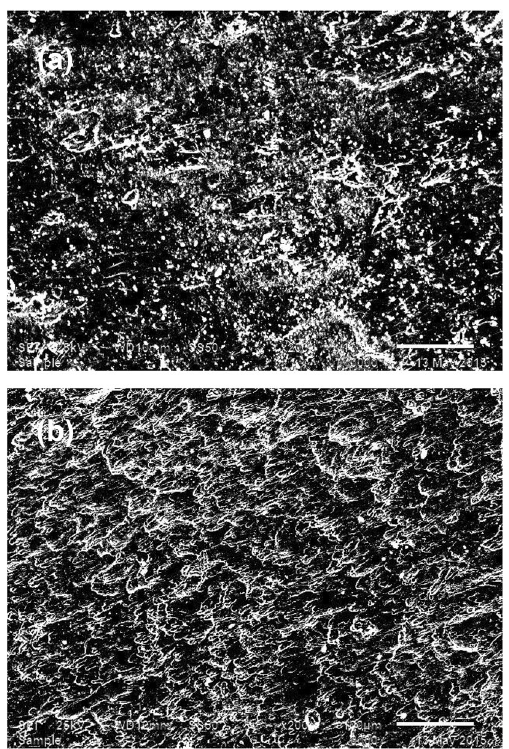
Figure 7. SEM images of ( a ) polished carbon steel, and ( b ) after 24 h of immersion in 3.5% NaCl and [BMIm]